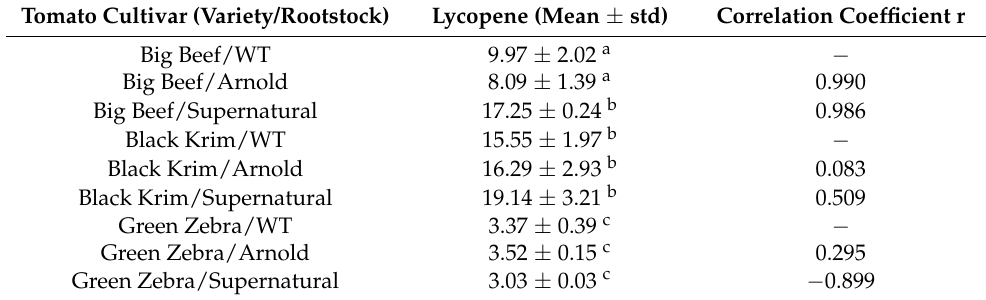
Table 2. Lycopene content (mg/kg dry weight) of tomato extracts. The lycopene content was significantly different for self-grafted Big Beef, Black Krim, and Green Zebra. Different letters (a, b, c) indicate statistical significance. A p -value of <0.05 was considered significant. Analysis using Pearson correlation showed a strong correlation between Big Beef grafted onto Arnold and Supernatural and Green Zebra grafted onto Supernatural, compared with their respective self-grafted cultivars. However, the correlation was not significant. The correlation coefficient of r < − 0.7 or r > 0.7 was considered a strong